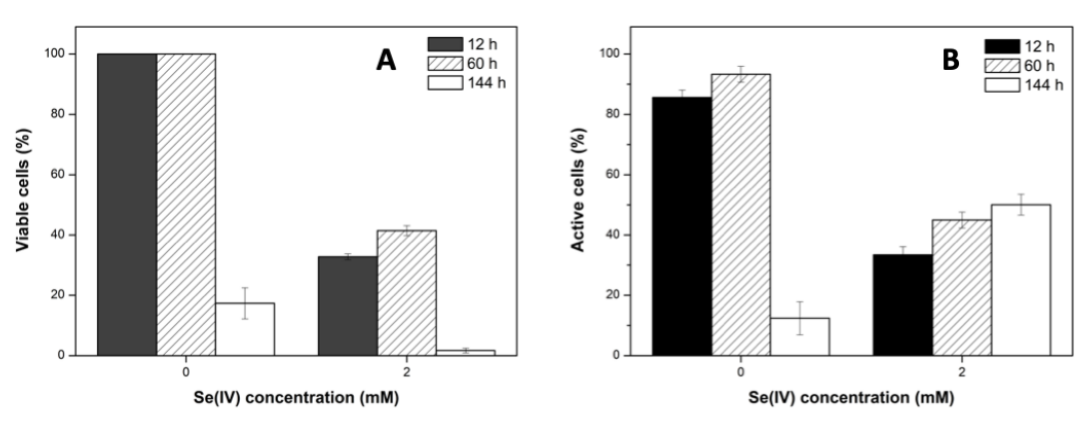
Figure 2. Percentage of viable ( A ) and active cells ( B ) of S. bentonitica under different Se IV concentrations (0 and 2 mM) and contact times (12, 60, and 144 h) under anaerobic and neutral pH conditions.